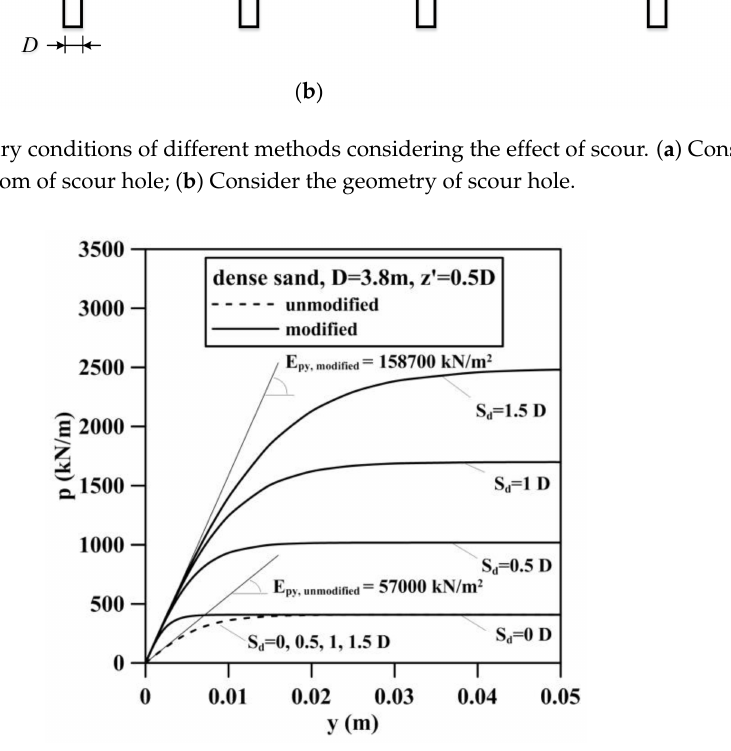
Figure 11. p – y curves for various scour depths at depth of 0.5 D below the bottom of the scour hole. (cid:16) (cid:17) E py , modified / E py , unmodified = 2.8